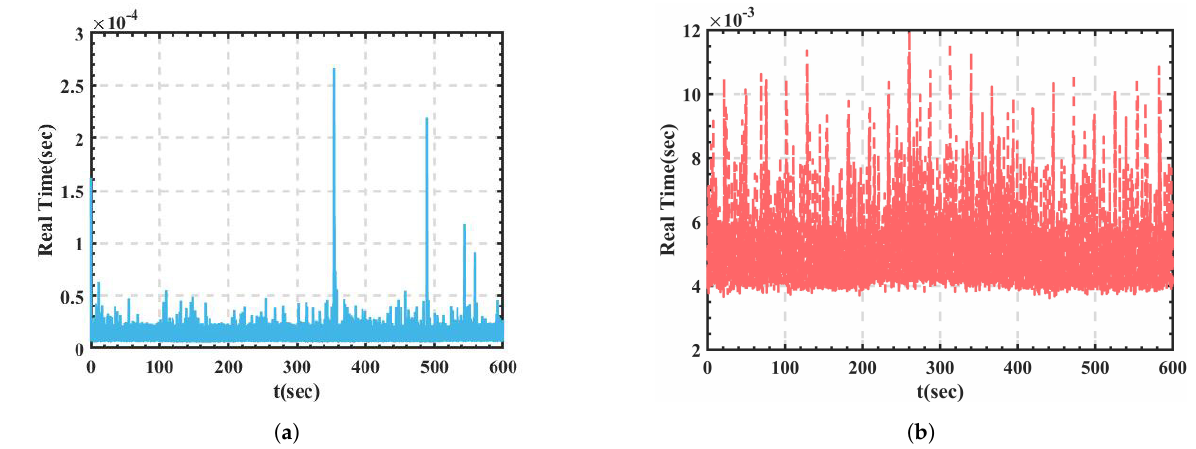
Figure 19. When n y = 5, at each sampling time: ( a ) mpQP-eMPC calculation time; ( b ) tMPC calculation